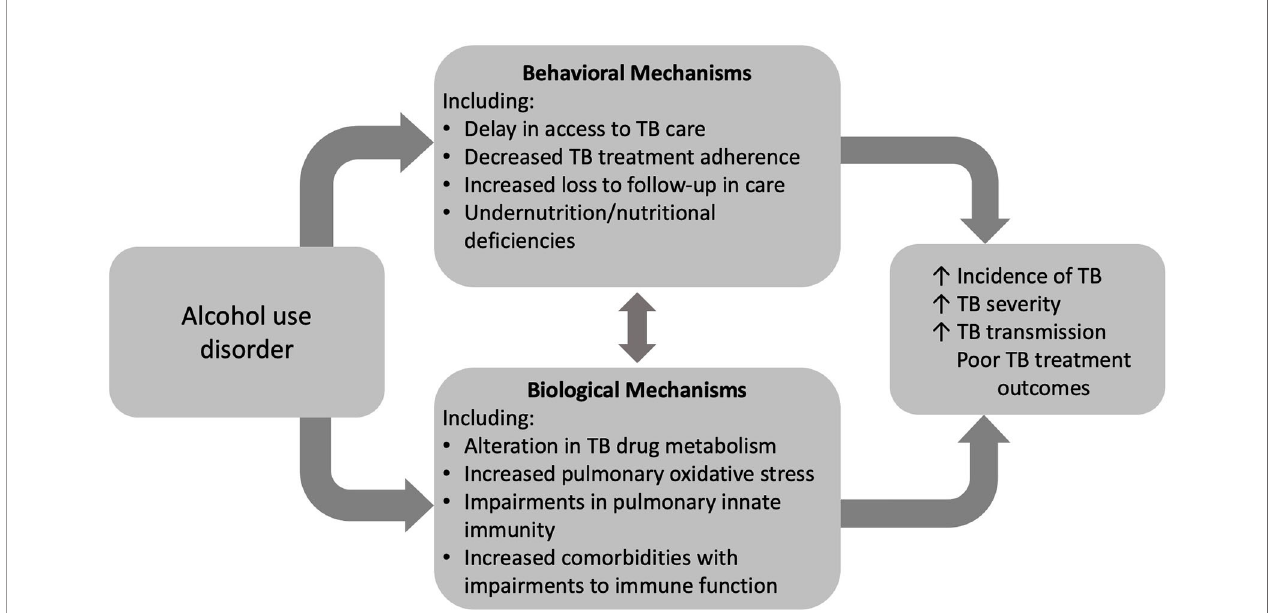
FIGURE 2 | Alcohol use disorder (AUD) in fl uences tuberculosis (TB) care and outcomes through both behavioral and biologic